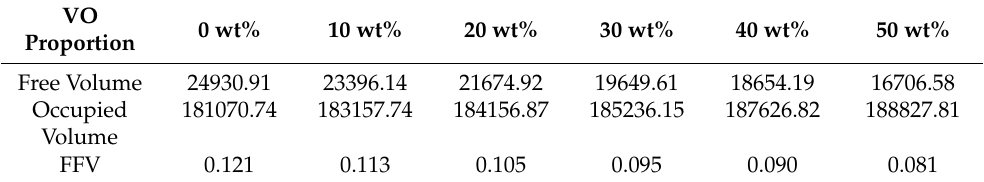
Table 17. The FFV of H 2 O molecules in each mixed oil model with 3 wt% water content.